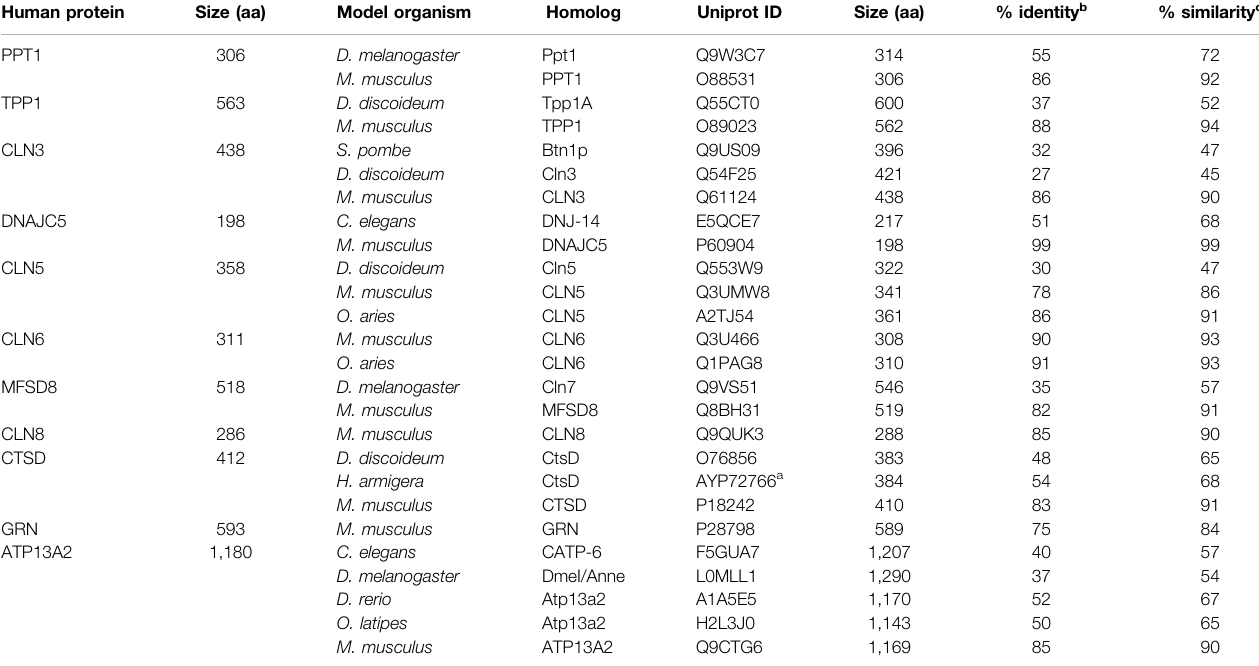
TABLE 2 | Model organisms used to study the roles of CLN genes and proteins in autophagy. Alignments were generated using NCBI, Protein BLAST (default search parameters) and the Uniprot ID, of each homolog as query sequences. Human protein Size